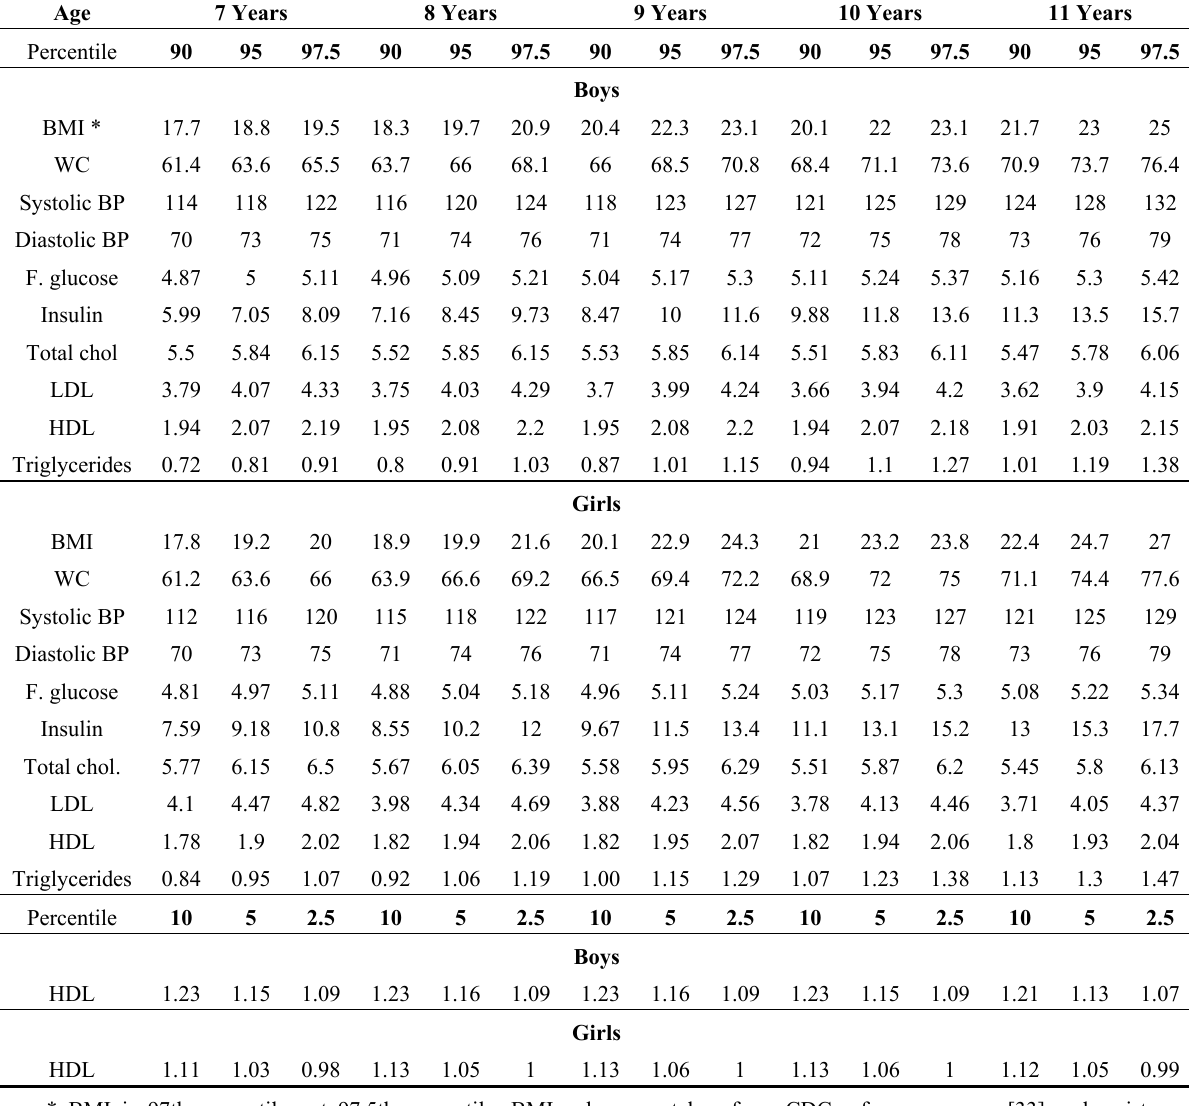
Table 1. Percentiles of clinical and biochemical cardiovascular disease (CVD) risk score factors by age and